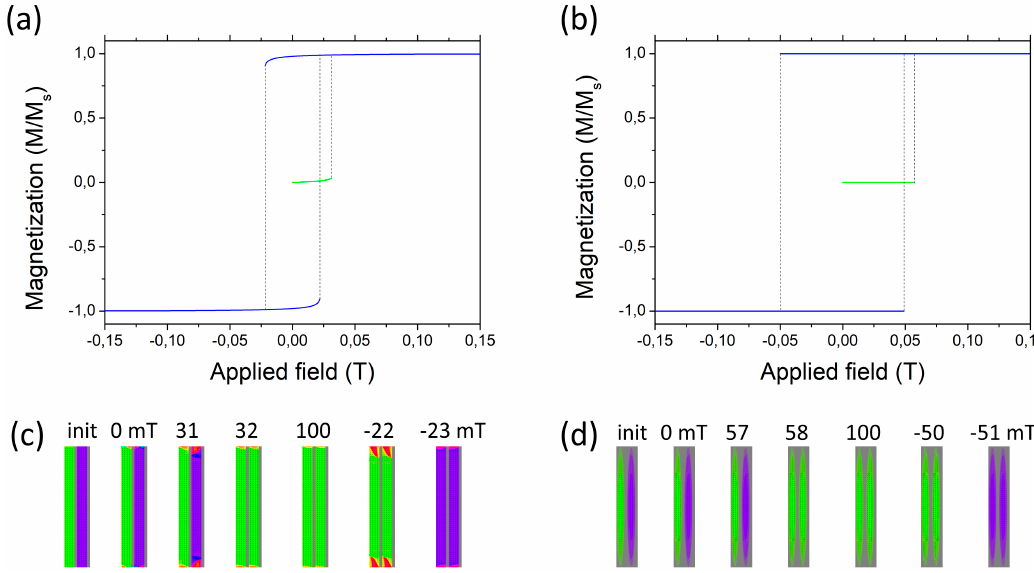
Figure 3. Magnetization sequence under the applied magnetic field in infinite chains of ( a ) stripes, ( b ) ellipsoids treated with micromagnetic simulations. Panels ( c , d ) illustrate magnetization maps for stripes and ellipsoids, respectively.